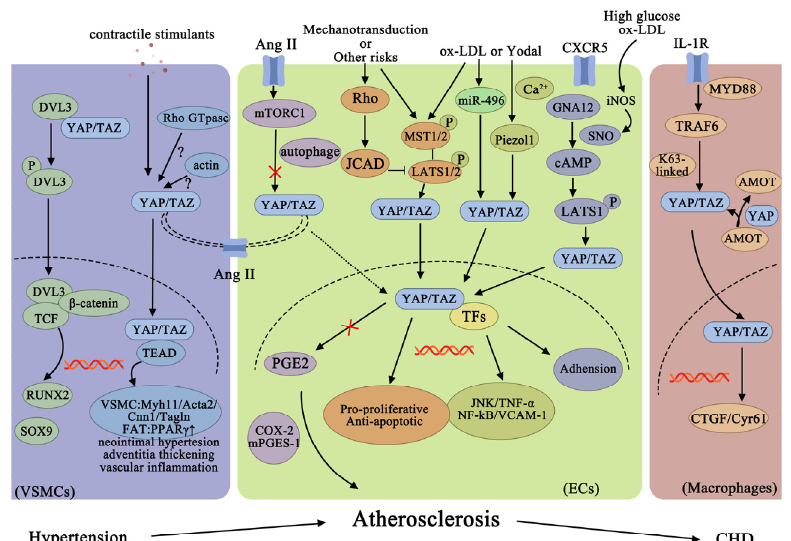
Figure 2. The role of YAP/TAZ of VSMCs, ECs, and macrophages in atherosclerosis and coronary heart disease. TCF, ternary complex factor; SOX9, SRY-box transcription factor 9; MYH11, muscle myosin heavy-chain 11; Acta2, actin alpha 2; Cnn1, calponin 1; Tagln, 22-kDa SMC lineage-restricted protein; PPAR γ , peroxisome proliferator-activated receptor gamma; ANG II, angiotensin II; PGE2, prostaglandin E2; COX2, cyclooxygenase 2; m-PGES-1, microsomal prostaglandin E synthase-1; TFs, transcription factors; i-NOS, inducible nitric oxide synthase; GNA12, guanine nucleotide-binding protein subunit alpha-12; SNO, S-nitrosylation; CXCR5, C-X-C motif chemokine receptor 5; MYD88, myeloid differentiation factor 88; K63-linked, lysine-63 (K63)-linked.